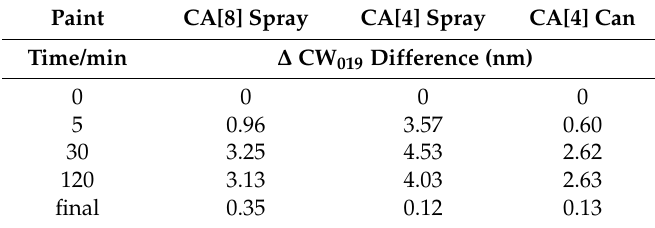
Table 3. Absolute shift of the central wavelengths difference during the paint experiments.